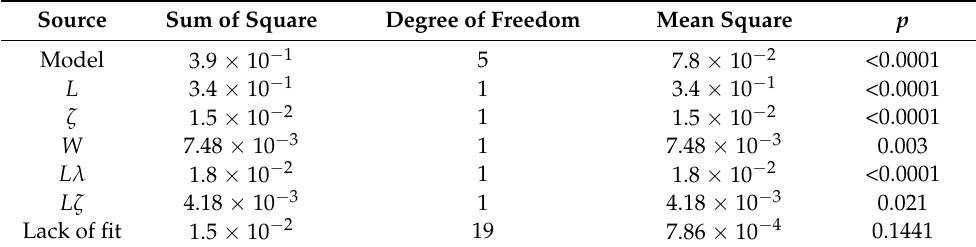
Table 6. Final significance analysis results of model Φ D .